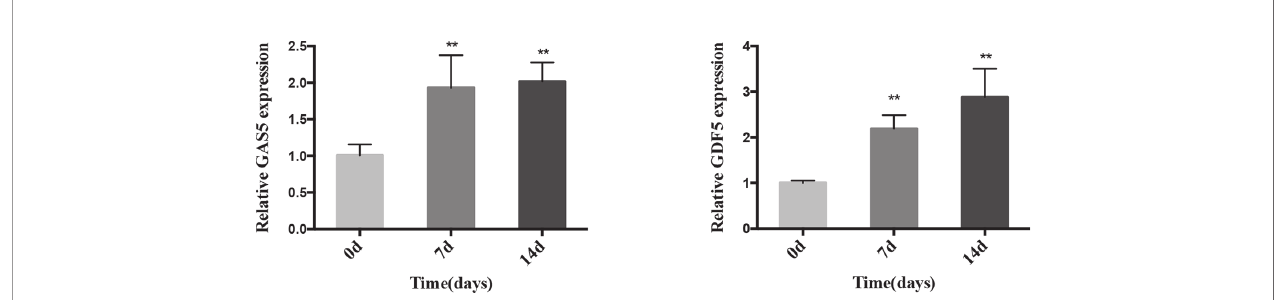
FIGURE 2 | Expression pattern of GAS5 and GDF5 during the osteoblast differentiation of hPDLSCs. The relative expression of GAS5 and GDF5 was determined by qRT-PCR during the osteogenesis of hPDLSCs for 0, 7 and 14 days. RNA expression at the above-mentioned time period was normalized to day 0. GAPDH was used as an internal control. **p <0.01. GAS5, lncRNA growth arrest speci fi c transcript 5; GDF5, growth differentiation factor 5; hPDLSCs, human periodontal ligament stem cells; GAPDH, glyceraldehyde 3-phosphate dehydrogenase; qRT-PCR, quantitative reverse-transcription polymerase